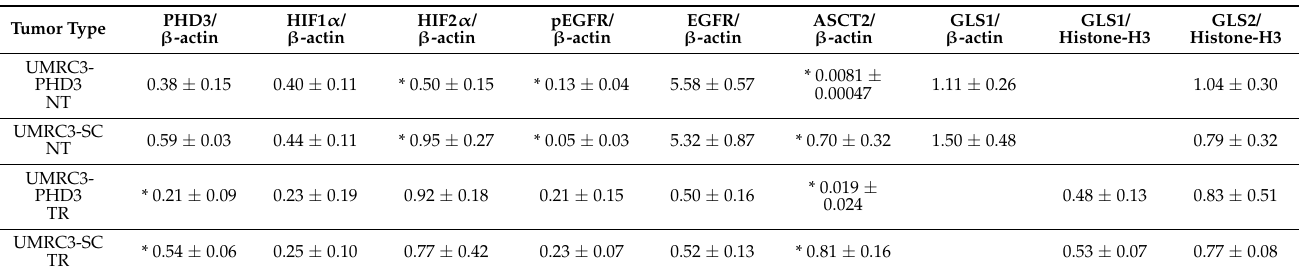
Table 1. Densitometry measurement of PHD3, HIF1 α , HIF2 α , pEGFR, and EGFR over loading control protein as visualized in Figure 4.